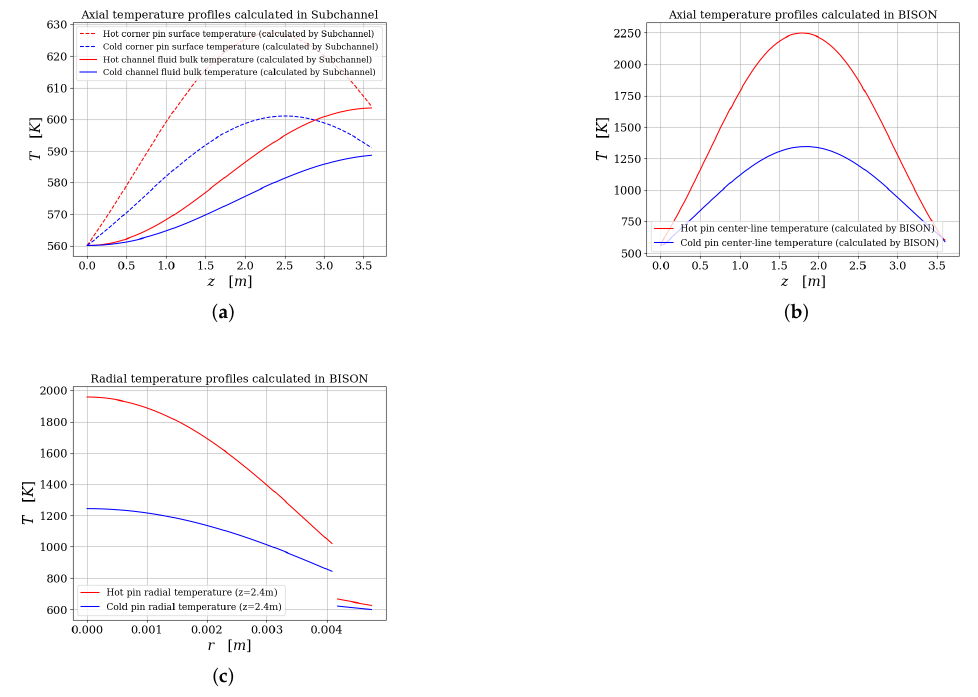
Figure 17. Axial and radial temperature profiles for the 4 × 4 PWR sub-assembly. ( a ) Axial subchannel temperature profile and axial pin surface temperature profile. ( b ) Axial center-line temperature profile for hot and cold pin. ( c ) Radial temperature profile for hot and cold pin at z = 2.4